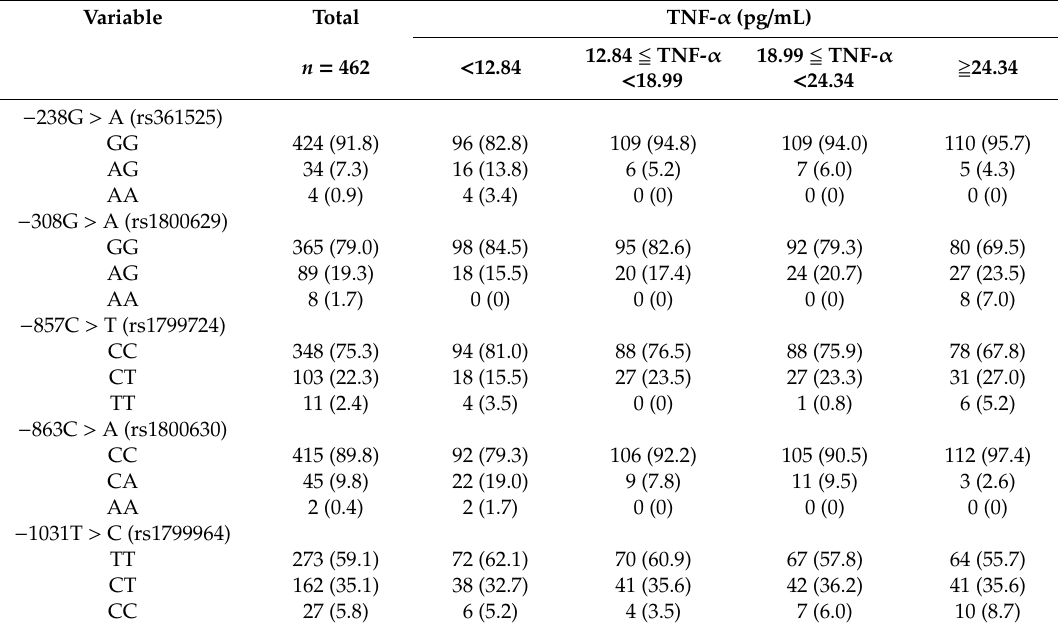
Table 2. TNF- α single nucleotide polymorphisms (SNPs) of all participants divided into quartiles according to serum TNF- α levels.